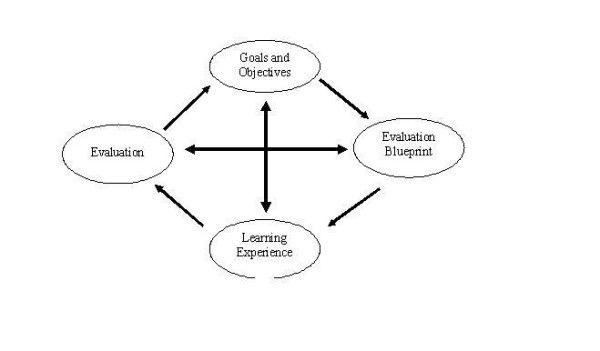
The Cybernetic Model.